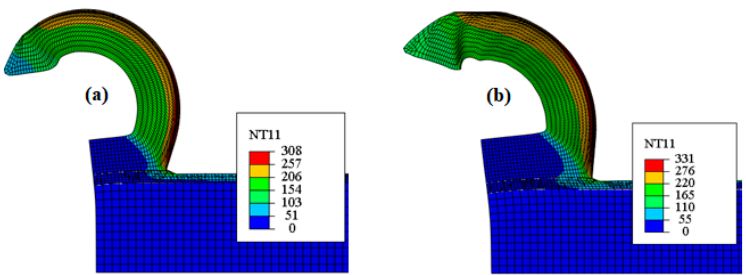
Figure 6. Nodal temperature ( ° C) distribution at Z = 0 ( a ) V C = 1000 m/min, f = 0.3 mm/rev, γ = 17.5° ( b ) V C = 800 m/min, f = 0.4 mm/rev, γ = 5°.